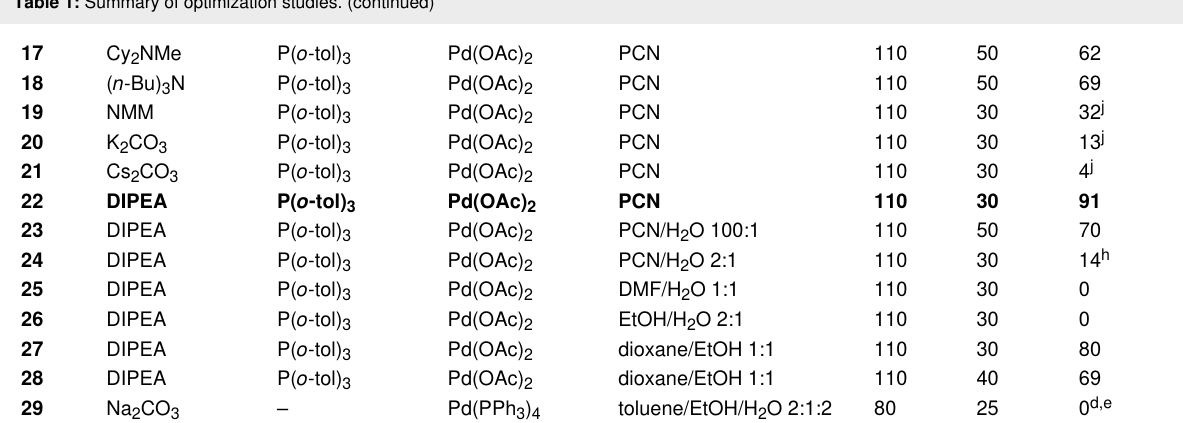
Table 1: Summary of optimization studies.